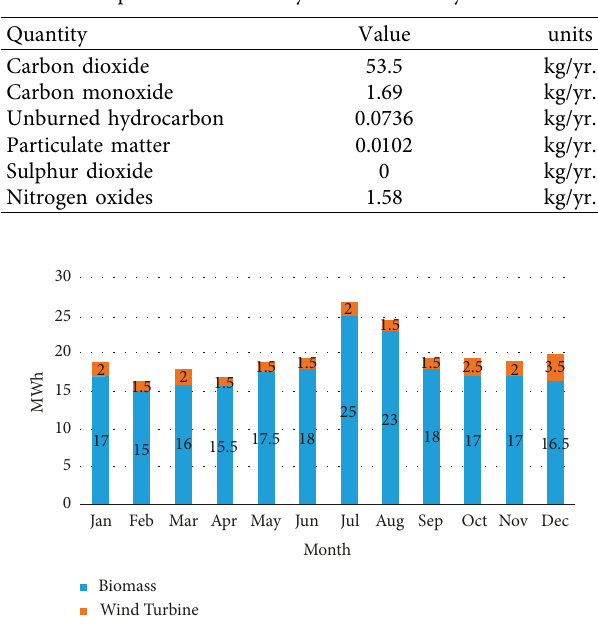
Figure 4: The cost summary of the scenario 2.